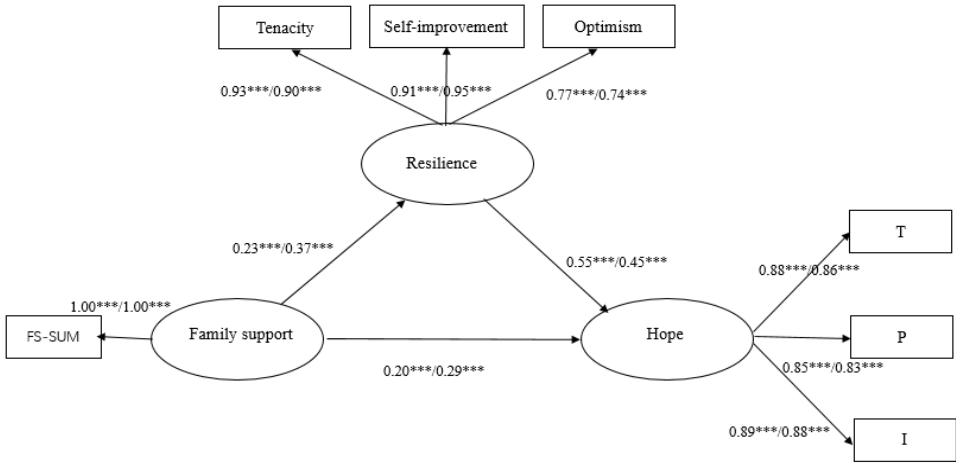
Figure 2. A multi-group analysis model of resilience of PWSUD between family support and hope. Note: The first data is the standard coefficient for the non-relapsers, and the second data is the standard coefficient for the relapsers. *** p < 0.001.